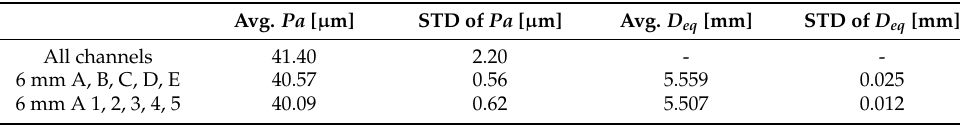
Table 2. Average Pa -values and repeatability investigation by comparison of D eq .